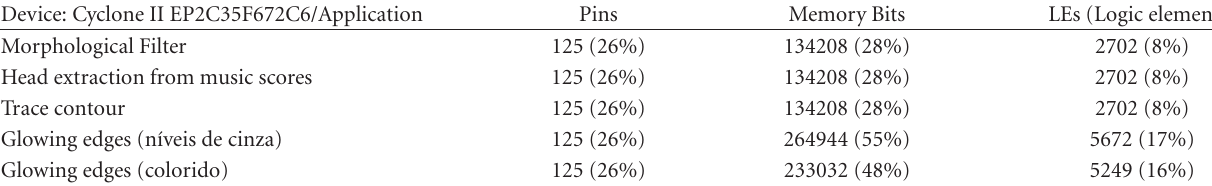
Table 3: Summary of FPGA